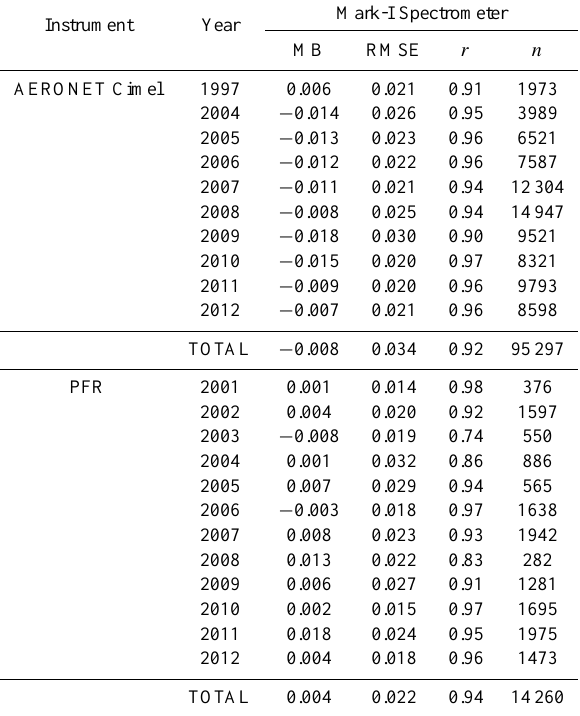
Table 2. The skill scores from AERONET/PFR versus Mark-I com- parison (transmitted component for 1997, 2001 and 2002, and scat- tered component from 2003 to 2012). Mean bias (MB), root mean square error (RMSE), Pearson correlation coefficient ( r ), and num- ber of cases ( n ). The total row indicates the scores obtained using the whole